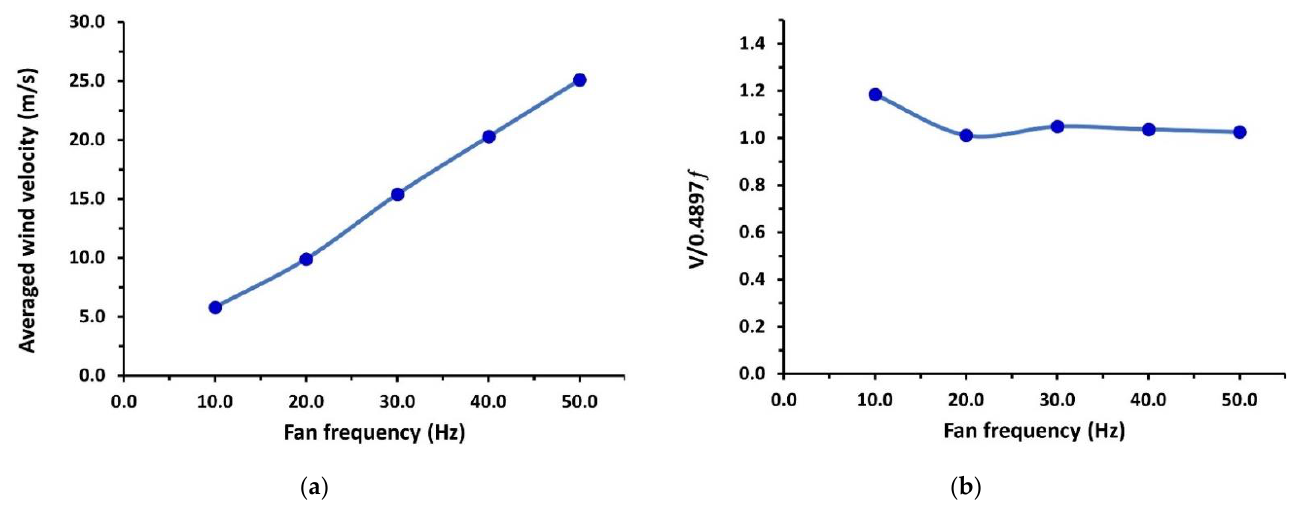
Figure 10. ( a ) The measured averaged wind velocity in the test section versus the fan frequency; ( b ) The normalized velocity versus the fan frequency. Table 2. The total pressure loss results for the wind tunnel components at the measured averaged maximum velocity (25.1 m/s).